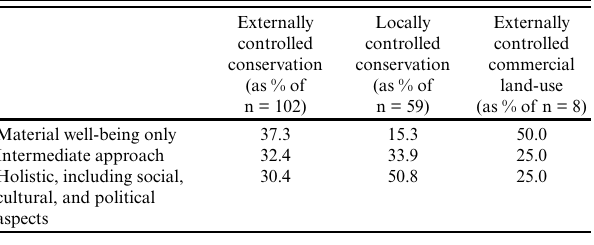
Table 2 . Type of social research approach applied in the 169 reviewed studies to cases exhibiting different forms of governance.